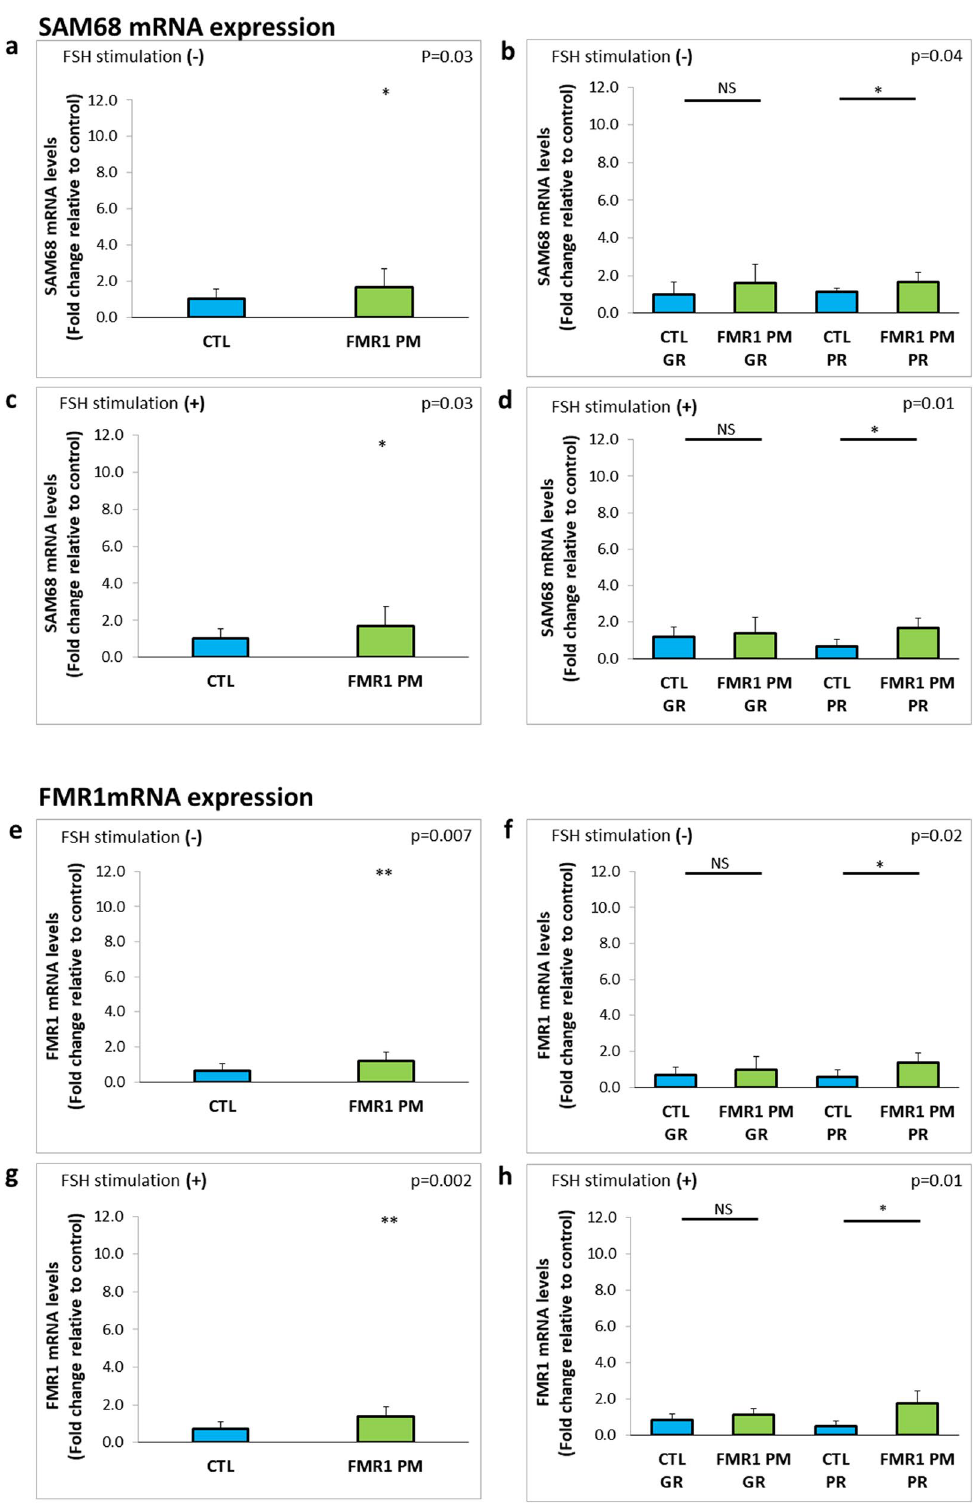
Figure 3. Higher SAM68 and FMR1 mRNA expression levels in MGCs of FMR1 premutation carriers compared to noncarriers. ( a ) SAM68 and ( e ) FMR1 mRNA expression levels in MGCs of FMR1 premutation carriers ( FMR PM) and noncarriers (CTL) without FSH stimulation. ( b ) SAM68 and ( f ) FMR1 mRNA expression levels in MGCs in sub-groups according to the oocytes number retrieved in OPU; GR > 5, PR ≤ 5. ( c ) SAM68 and ( g ) FMR1 mRNA expression levels in MGCs following 48 h of FSH stimulation. ( d ) SAM68 and ( h ) FMR1 mRNA expression levels in FSH-stimulated MGCs by number of oocytes retrieved in OPU: GR > 5, PR ≤ 5. *p < 0.05, **p < 0.01, ***p < 0.001. Graphs show fold change relative to control expression ±